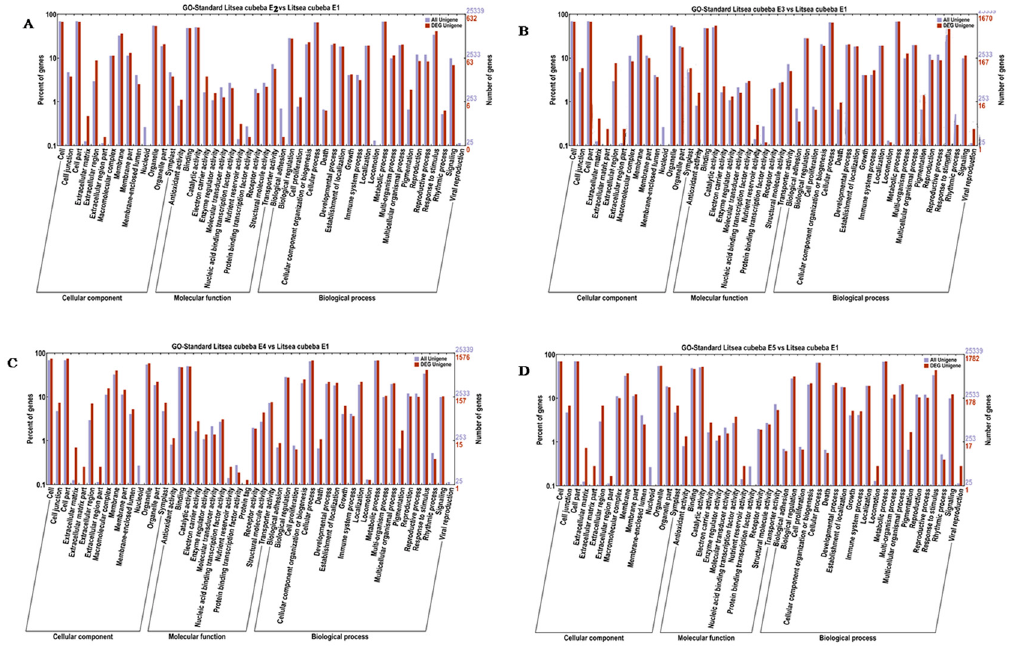
Figure 4 . Functional categorization of the differentially expressed genes during development of L. cubeba fruit. ( A )–( D ) shows the functional categorization of the differentially expressed genes between the 75 DAF, 90 DAF, 105DAF, 135 DAF and 60 DAF (as control) developmental stages.